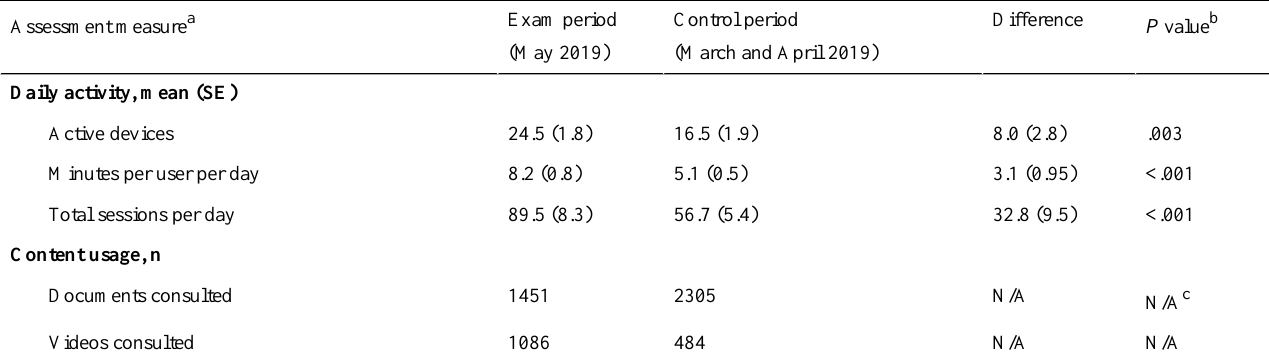
Table 2. Pregraduate assessment of utilization during the control period compared to the exam period within 251 HeadToToe app downloads among medical students at the University of Geneva,